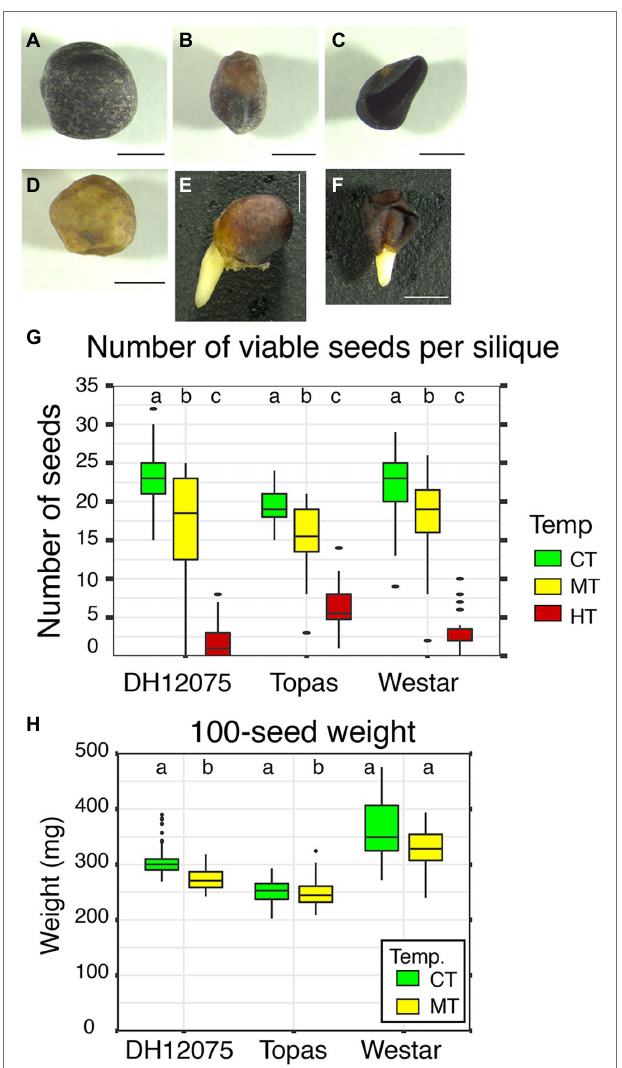
FIGURE 5 | Effects of high temperatures on seed development. (A–F) Range of phenotypes observed in mature seeds. We observed normal fully filled seed (A) , partially filled seed (B) , flatten shrunken seed (C) , partially filled yellow seed (D) , sprouting fully filled seed (E) , sprouting flatten shrunken seed (F) . Scale bars represent 1 mm. (G) Graph displaying the number of viable seeds per silique in DH12075, Topas, and Westar cultivars at CT (green), MT (yellow), and HT (red). (H) Graph displaying 100-seed weight in DH12075, Topas, and Westar cultivars at CT (21/18 ° C, green) and MT (28/18 ° C, yellow). The data (G,H) are presented in boxplots. The box represents the interquartile range, and the black line inside the box represents the median. Dots represent outliers. Boxes with the same letters (a, b, and c) within each cultivar do not differ significantly ( p < 0.05).